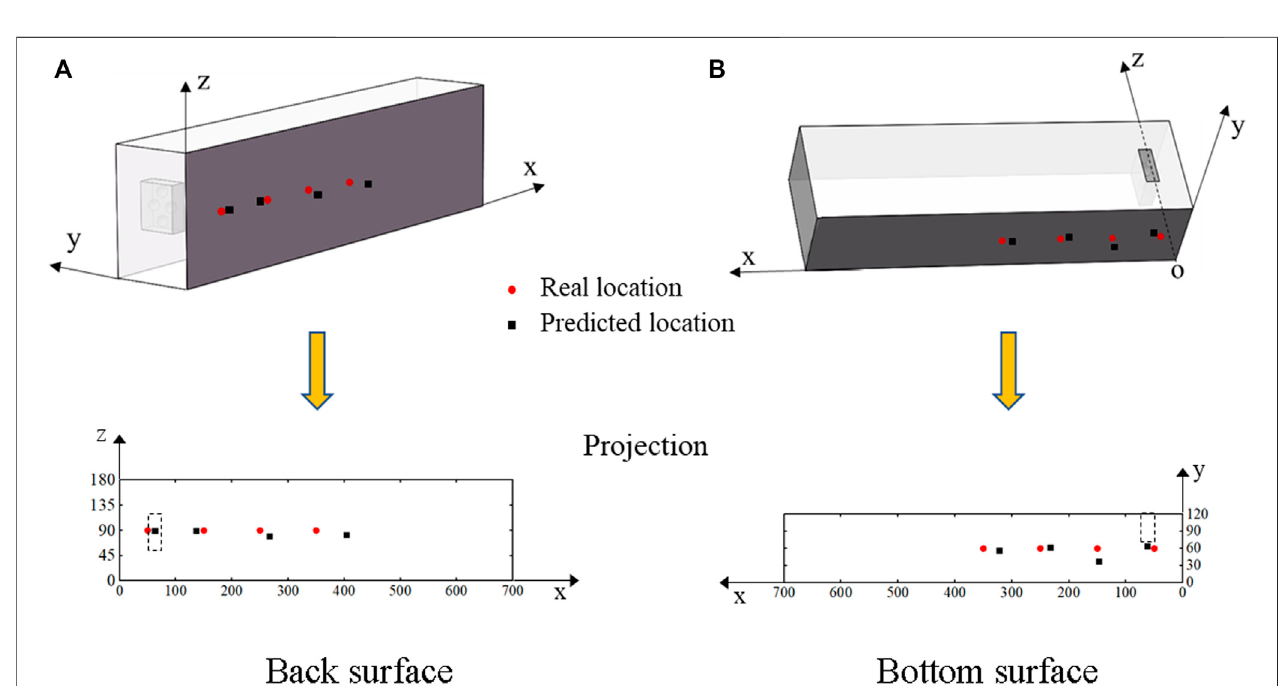
FIGURE 13 | Real and predicted impact locations and their projections on the beam surfaces. (A) Back surface. (B) Bottom surface.